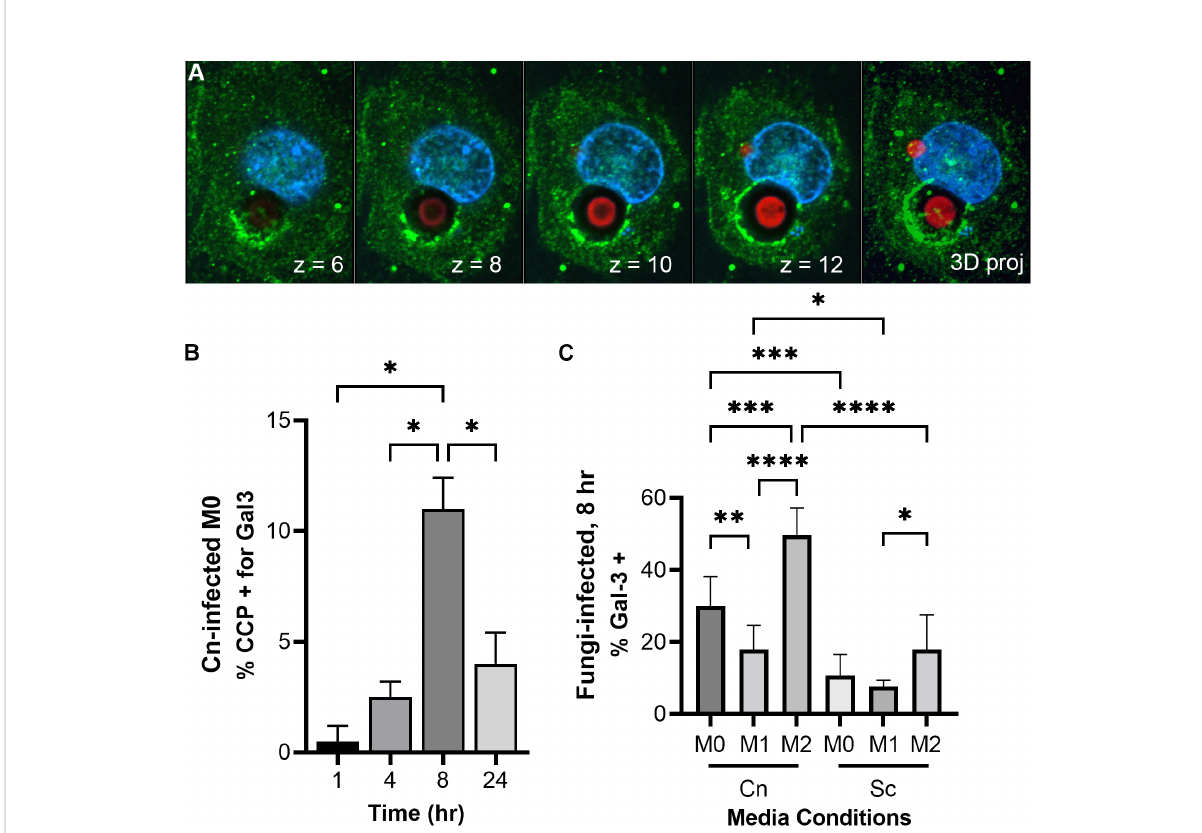
FIGURE 4 C. neoformans damages and permeabilizes its phagosome early after infection in an immune signal-dependent way. (A) Images from a representative THP-1 cell (nuclei in blue) 24 hr-post infection with C. neoformans (red) showing membrane damage around one cryptococcal- phagosome (Gal-3 in green). The number on the lower right represent the Z-slice on a series of pictures that are reconstructed into a full projection on the last image to the right. The dark halo surrounding the cell represents its polysaccharide capsule. (B) Quanti fi cation of Gal-3 staining over time in M0 THP-1 cells infected with C. neoformans (Cn). CCP, cryptococcal-containing phagosome. (C) Quanti fi cation of Gal-3 staining at 8 hr in M0, M1, and M2 THP-1 cells infected with Cn or S. cerevisiae (Sc). Statistics are ordinary one-way ANOVA with multiple comparisons. *, P < 0.05; **, P< 0.01; ***, P < 0.001; ****, P <